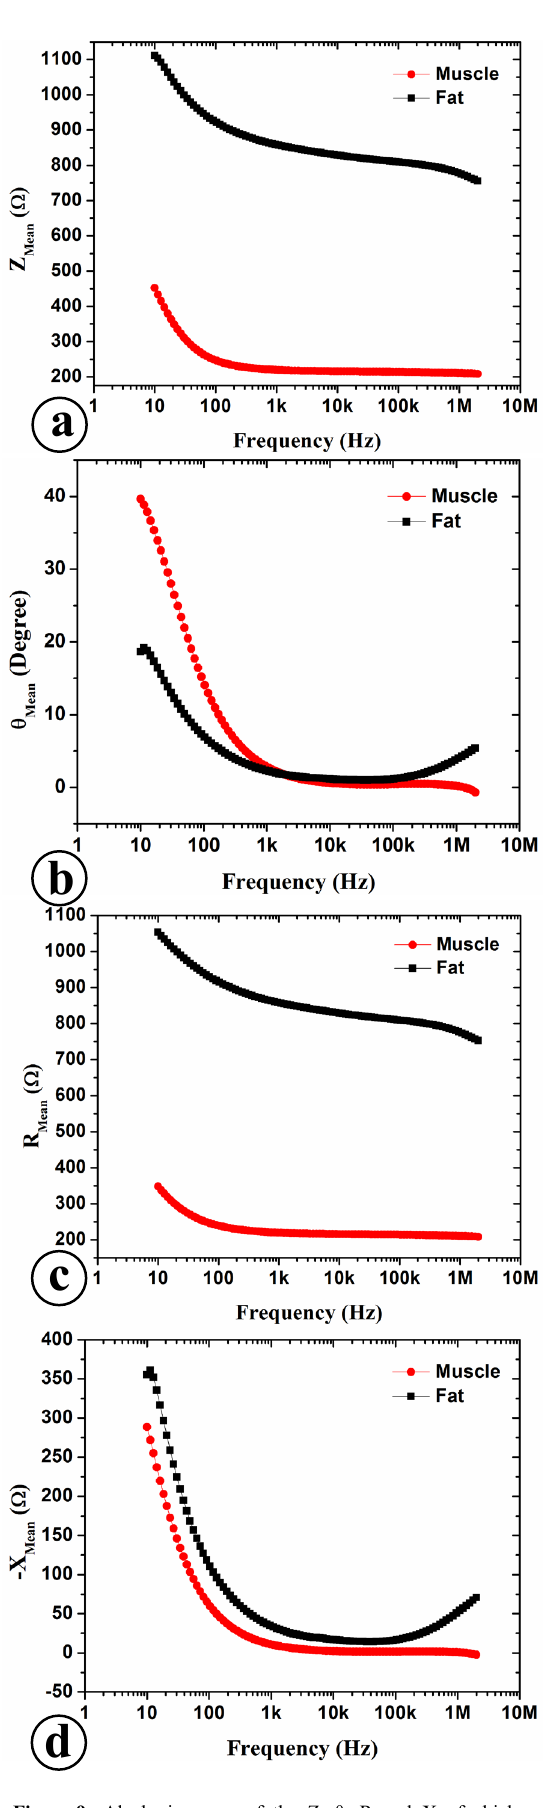
Figure-9: Algebraic mean of the Z, θ , R and X of chicken muscle tissue paste and fat tissue: (a) Z, (b) θ, (c) R, (d) X